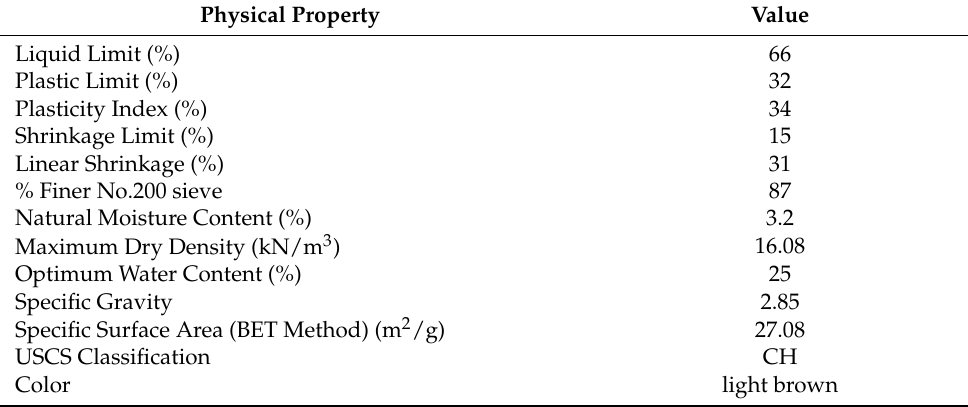
Table 1. Physical properties of studied